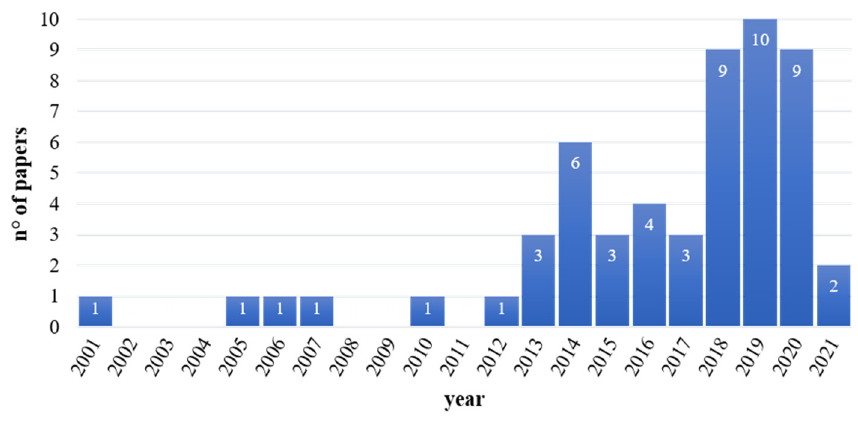
Figure 2. Temporal distribution (number of papers published per year) of selected papers.